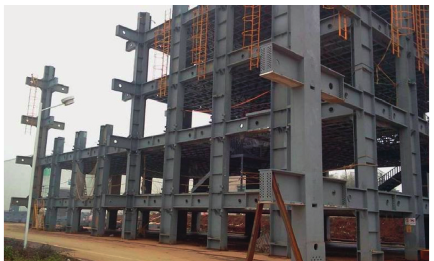
Figure 1: Splicing joint of steel frame beam in practical